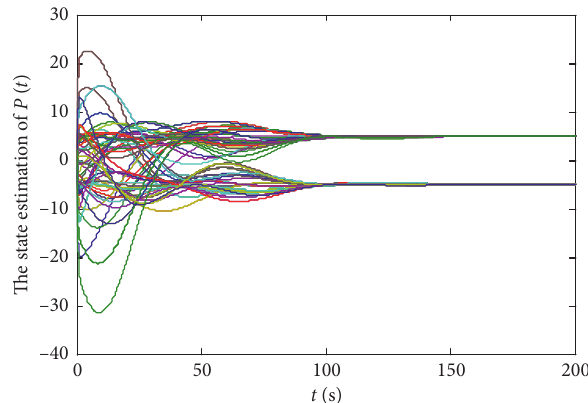
Figure 3: The response curves of the estimation matrix 􏽢 P ( t )